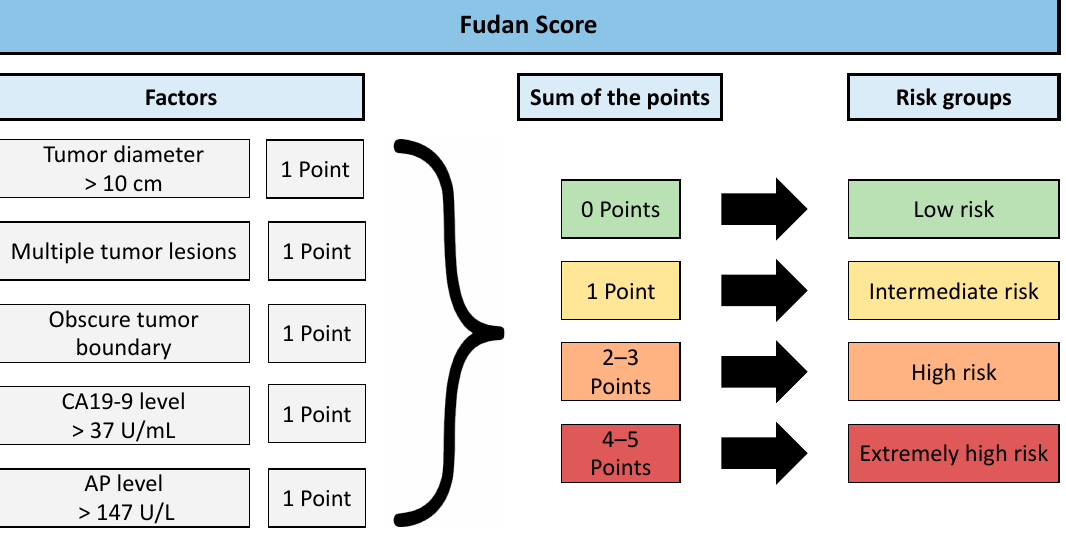
Figure 2. Calculation of the Fudan score. CA19 ‐ 9, carbohydrate antigen 19 ‐ 9. AP, alkaline phosphatase.